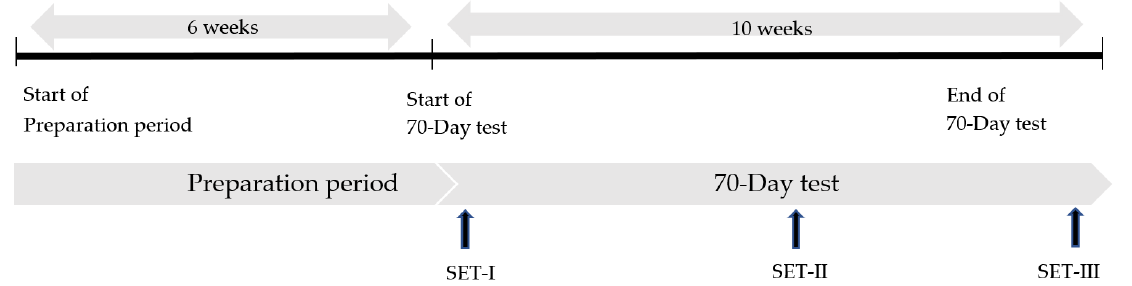
Figure 1. Training schedule of young Friesian horses during the preparation period and the 70-day test, including standardized exercise tests (SETs).